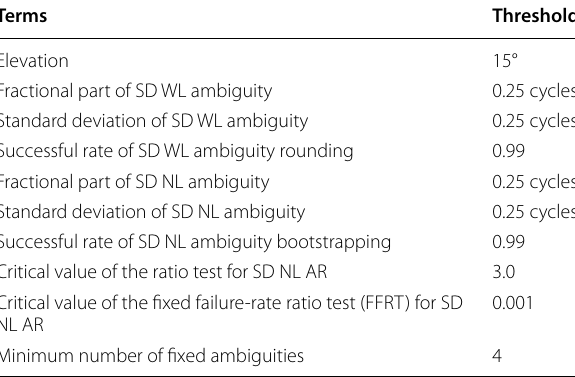
Table 1 Quality control strategies for UCPPP